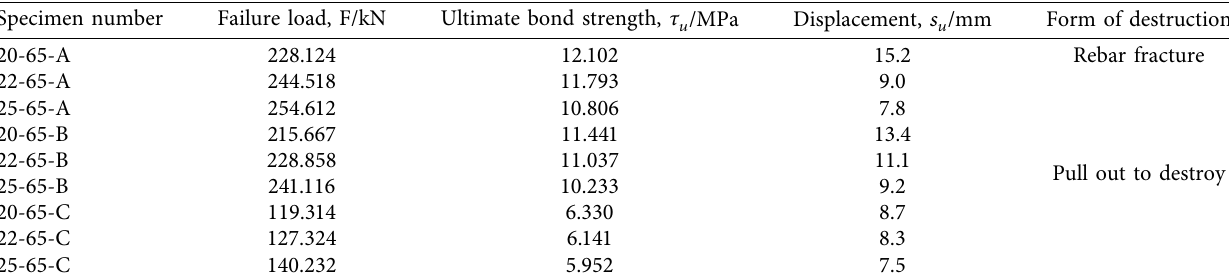
Table 3: Test results.